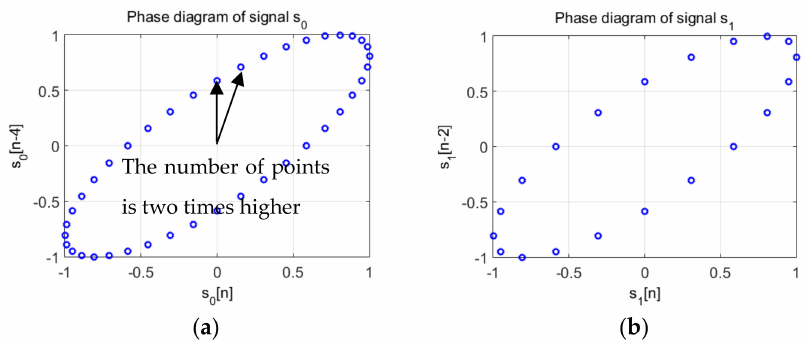
Figure 13. ( a ) The phase space trajectory of the signal s 0 from Equation (19); ( b ) The phase space trajectory of the signal s 1 from Equation (19); The number of samples of each trajectory is inversely proportional with the